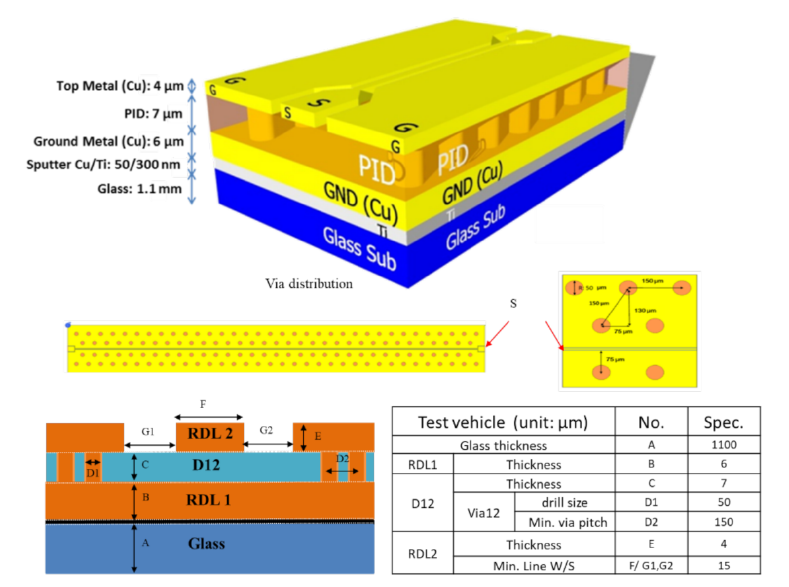
Figure 9. Detailed test vehicle designed by